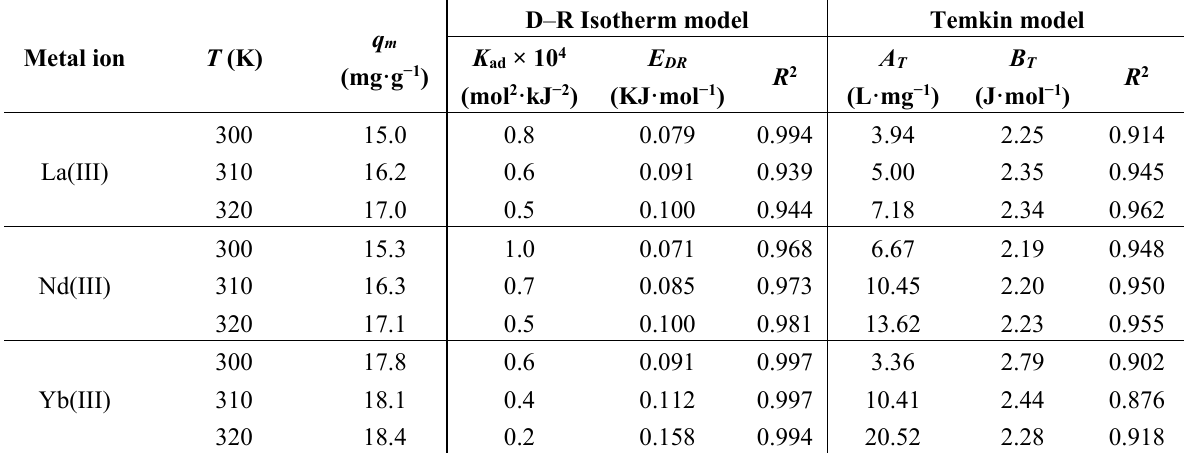
Table 4. Parameters of the Dubinin–Radushkevich (D–R) and Temkin equations for the sorption of La(III), Nd(III) and Yb(III) metal ions using cysteine-based magnetic-chitosan nanoparticles at different